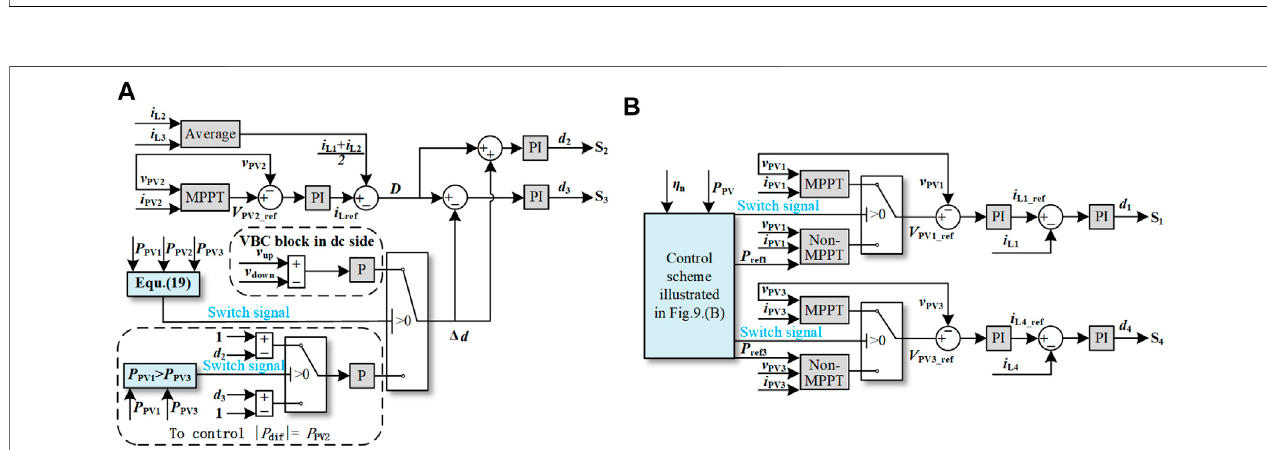
FIGURE 9 | Flow chart of (A) coordinated control scheme between the proposed converter and the rear-end inverter. (B) Switching the control mode of each PV source and generating its power reference at non-M.